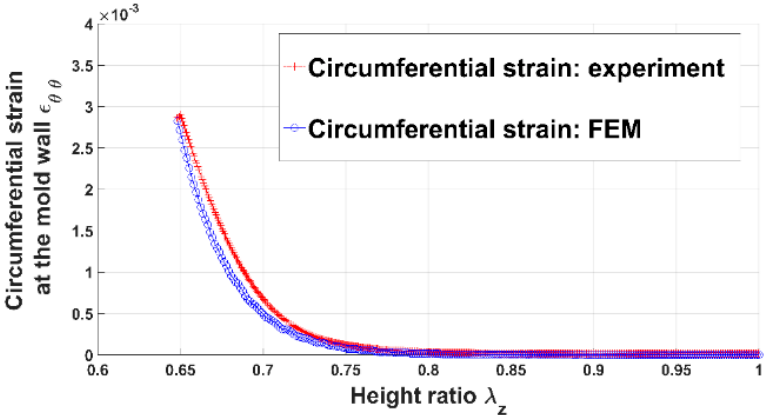
Figure 18. Radial pressure: FEM vs. experiment.